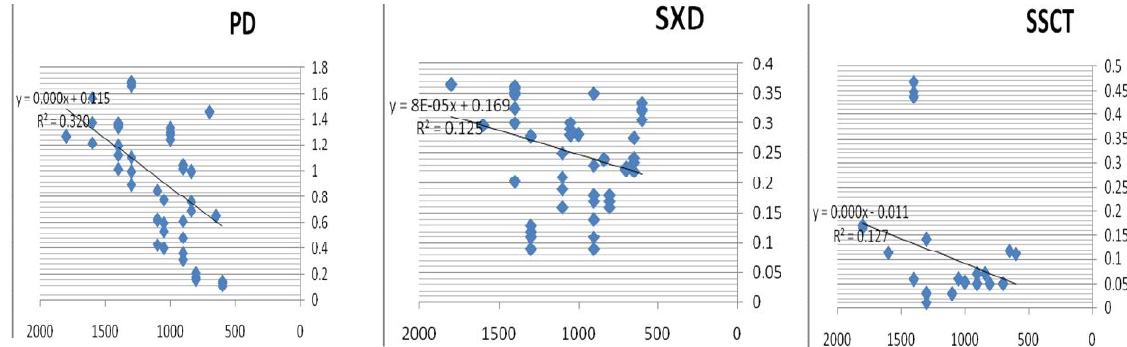
Fig. 6. Relationship between SXD, PD, SSCT and altitude in C. orientalis: SXD- Stem xylem diameter; PD- Petiole diameter; SSCT- Stem epidermis